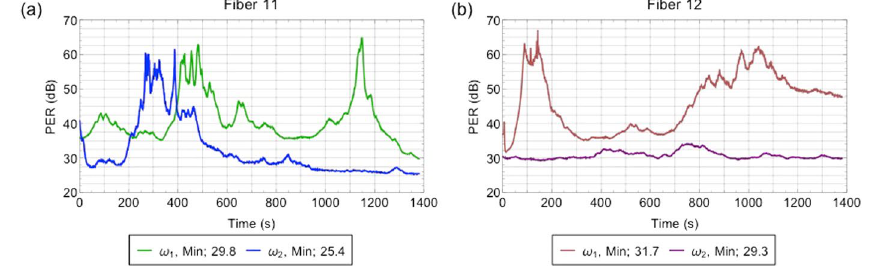
Figure 4. PER of the Raman fibers. ( a ) PER of the two frequencies required to drive a Raman transition through the first Raman beam path - fiber (11). Green is ω 1 , whose minimum PER is 29.8 dB, and blue is ω 2 , whose minimum PER is 25.4 dB. ( b ) PER of the two frequencies required to drive a Raman transition through the second Raman beam path - fiber (12). Brown is ω 1 , whose minimum PER is 31.7 dB, and purple is ω 2 , whose minimum PER is 29.3 dB.